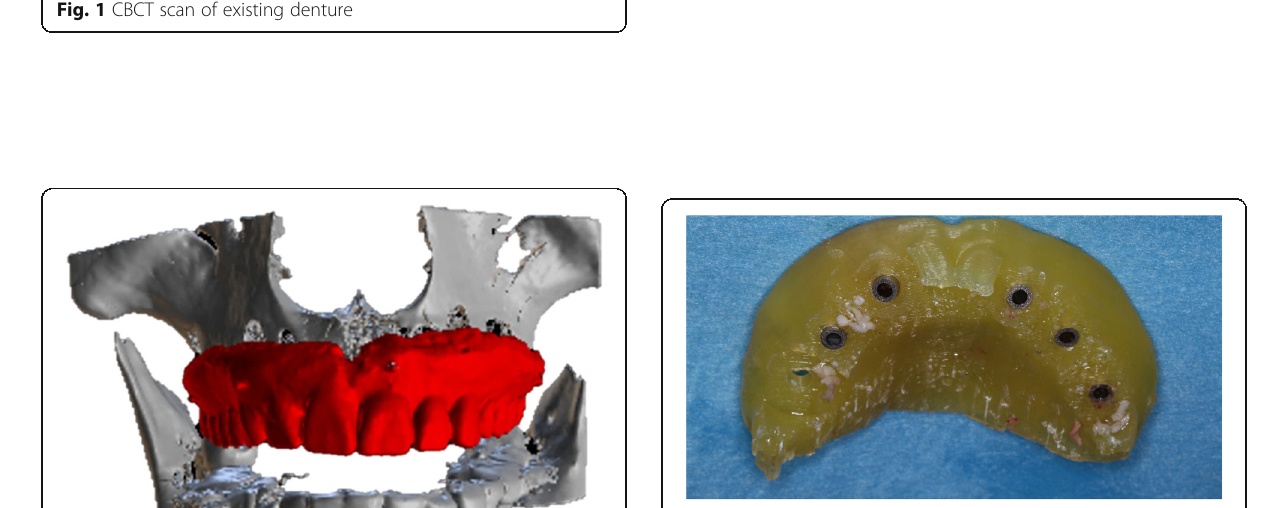
Fig. 4 3D-printed surgical guide